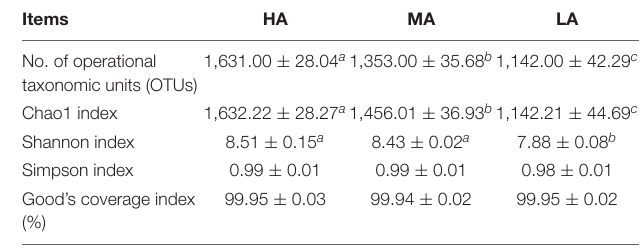
TABLE 5 | Diversity indices of ruminal microbiota of